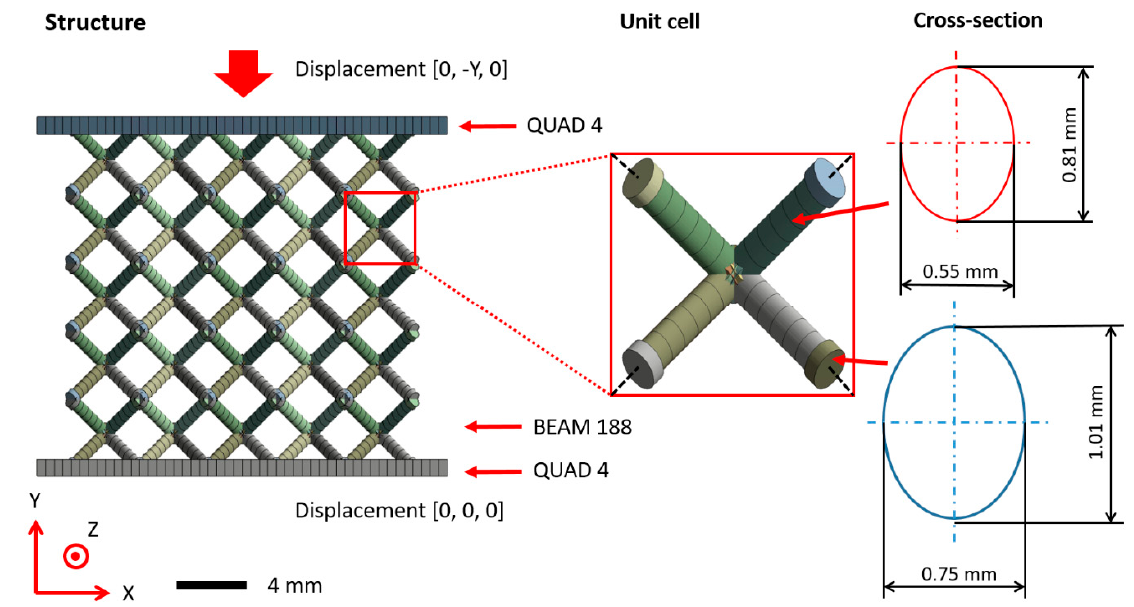
Figure 6. Segmented beam element model of BCC lattice structure including geometrical imperfection (for 0.6 mm nominal strut diameter).